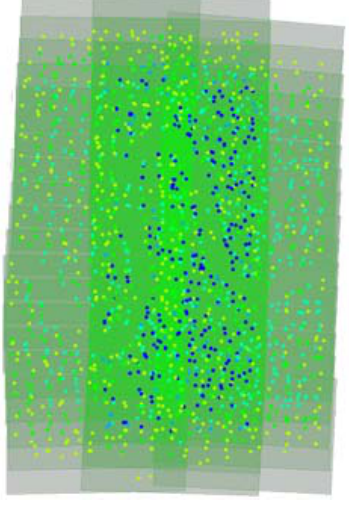
Figure 3. The footprint of UCD images